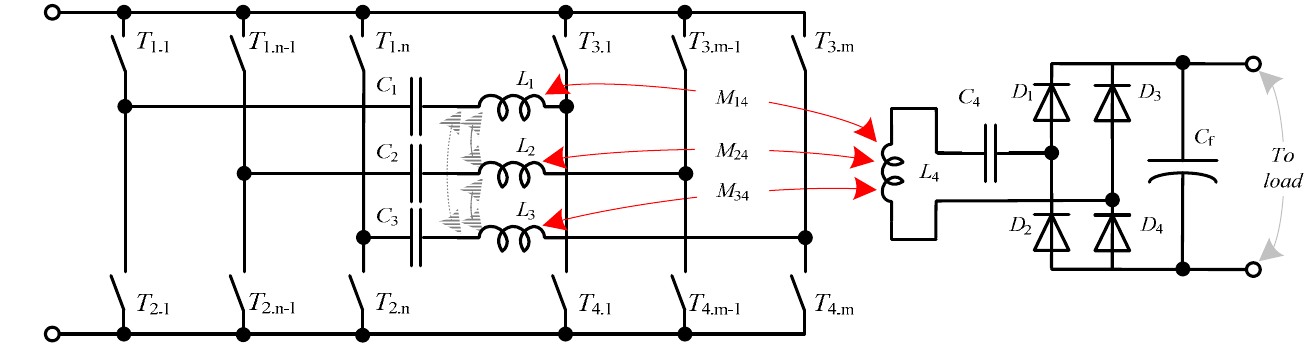
Figure 4. Inductive power transfer topology with three transmitters.